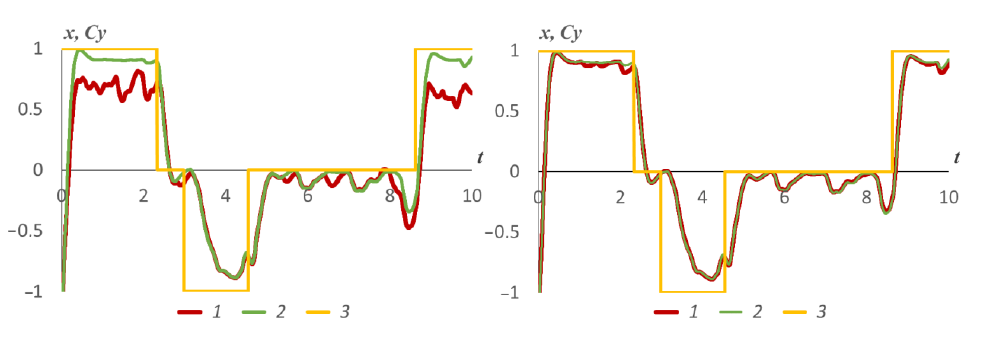
Figure 5. Typical controlled state trajectories with low control cost in the semi-stable system: ( left ) 1— coordinate x t , controlled by (cid:98) u t coordinate x t , controlled by (cid:98) u t